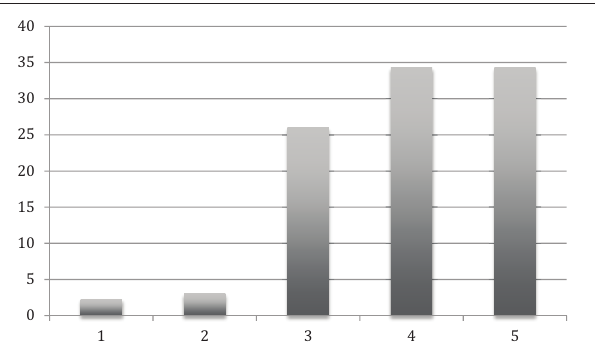
Figure 4) Per cent of response to “I had more interest in